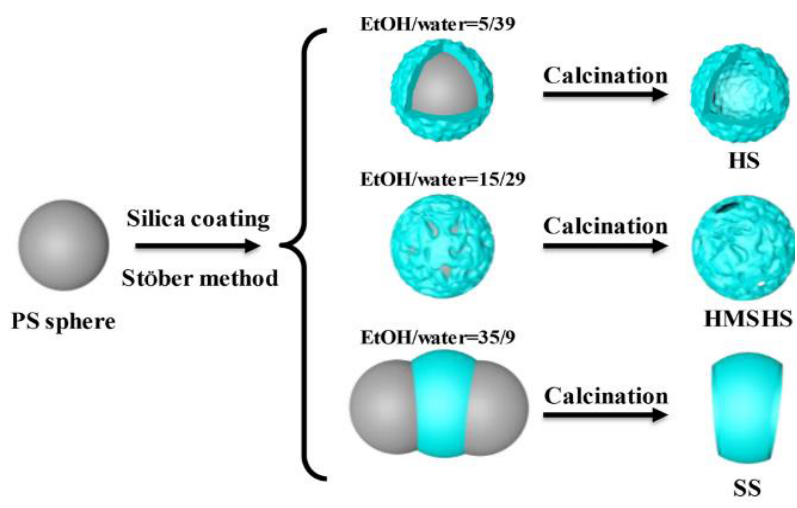
Figure 22. Schematic diagram of the effect of EtOH/water on the morphology. HS = hollow silica, HMSHS = large through-holes on the shell, and SS = sandwich-like silica